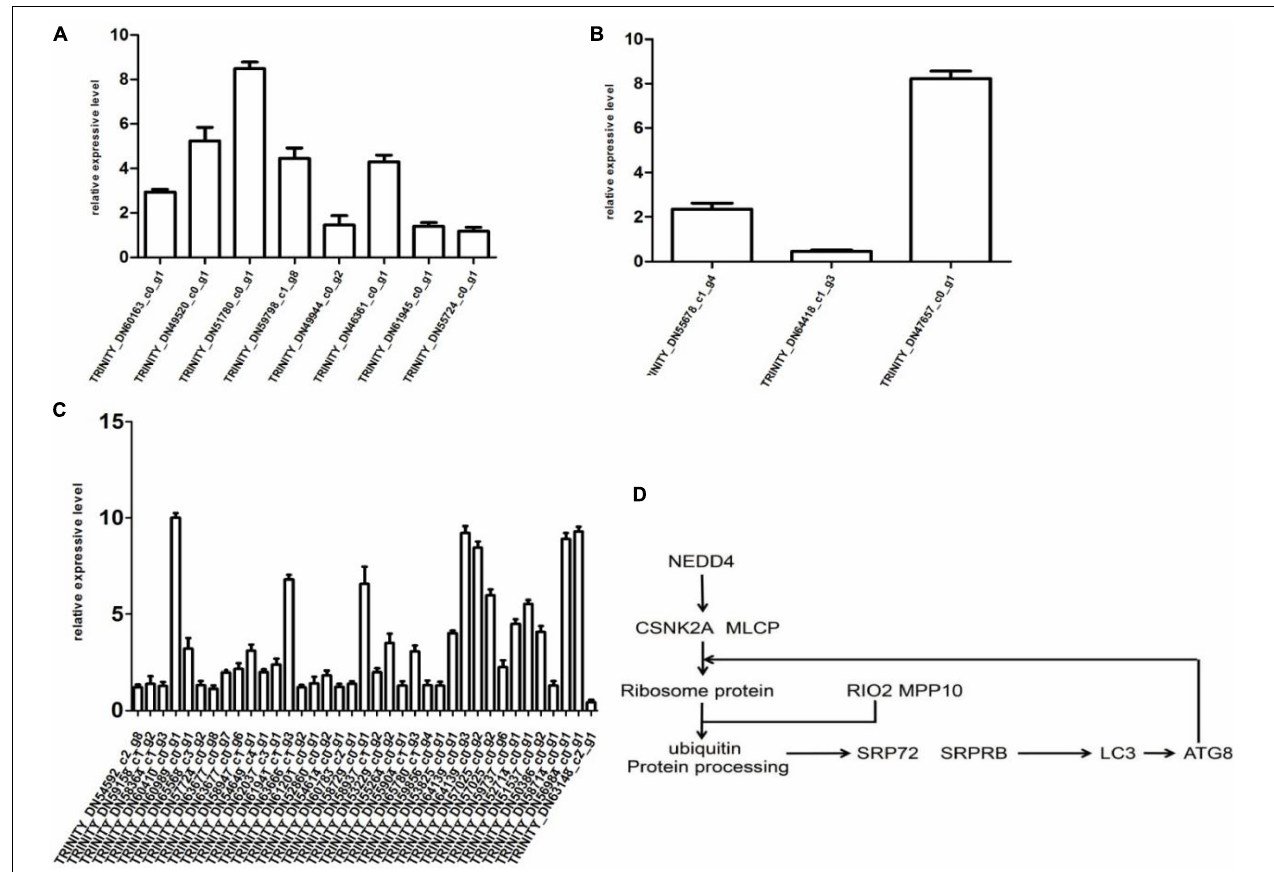
FIGURE 4 | Differential expression multiple of the gene histogram shows genes express differentially in the control and test groups. Panels (A–C) represent endocytosis, PEX protein and viral protein synthesis, and ER stress response. Panel (D) represents the partial path of CP72-1210 response to ScYLV infection.